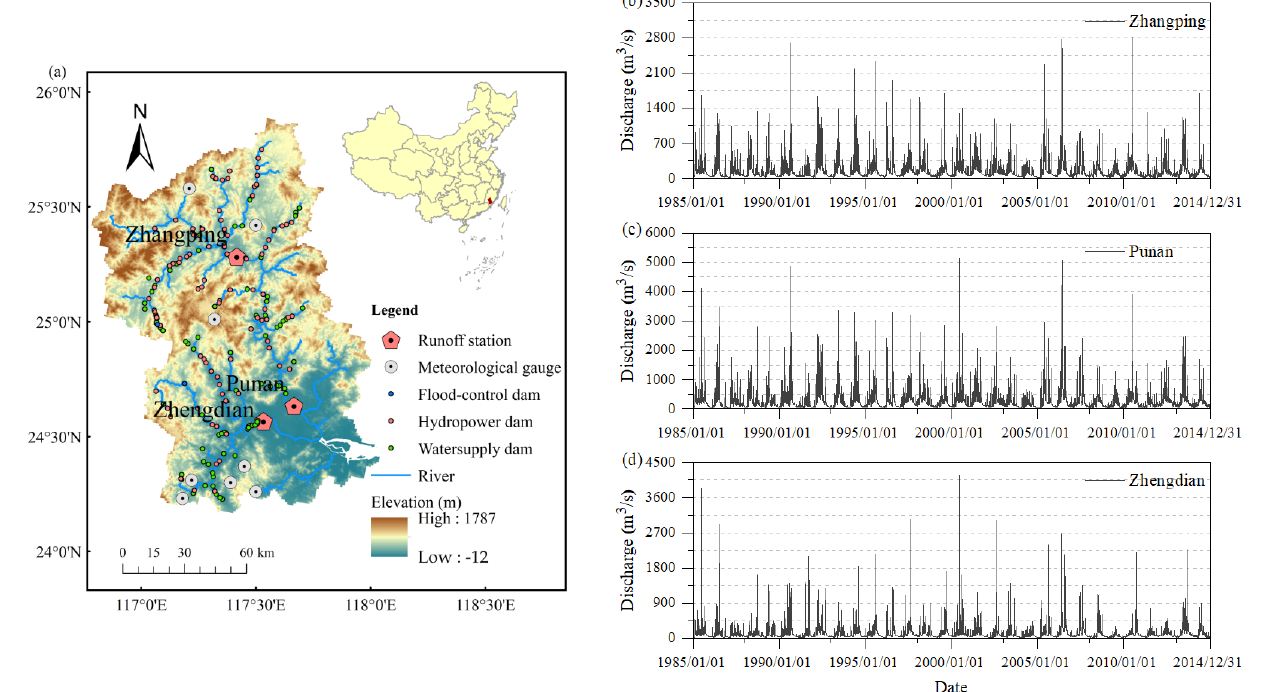
Figure 1. Study area in the Jiulong River basin ( a ) and the hydrographs of hydrological stations in Zhangping ( b ), Punan ( c ) and Zhengdian ( d ).